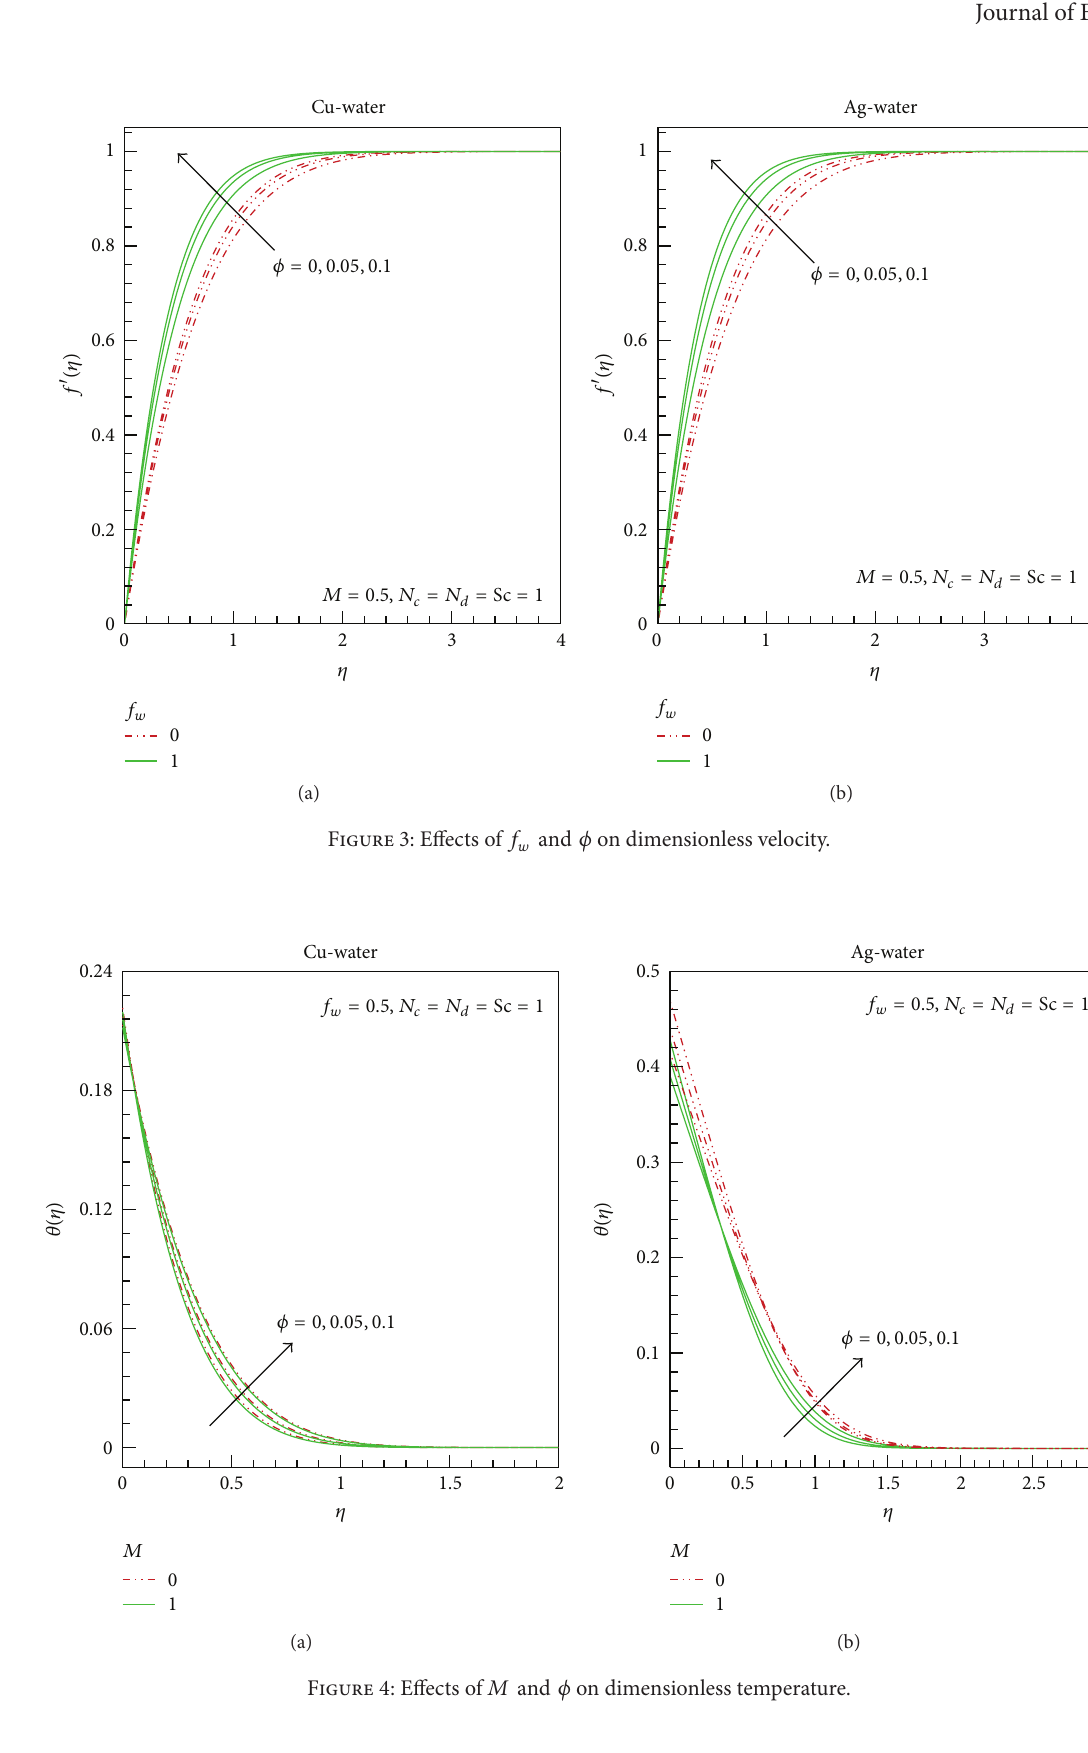
Figure 4: Effects of 𝑀 and 𝜙 on dimensionless